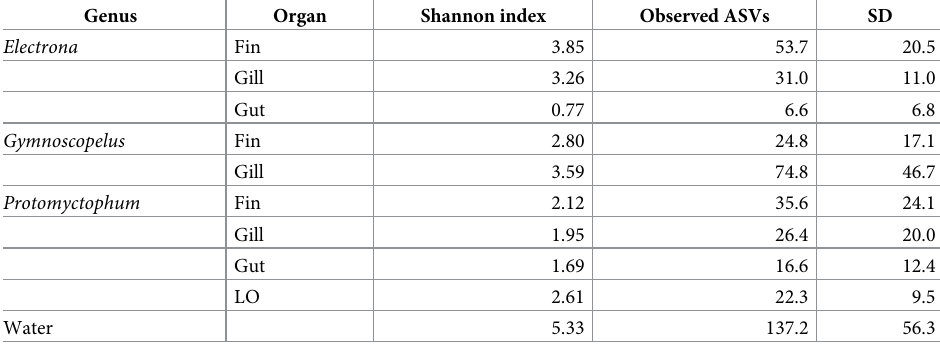
Table 2. Mean values for Shannon index, and mean observed ASVs and associated standard deviation in each body part (for which sample number exceeds 1) of each genus and in water. Genus